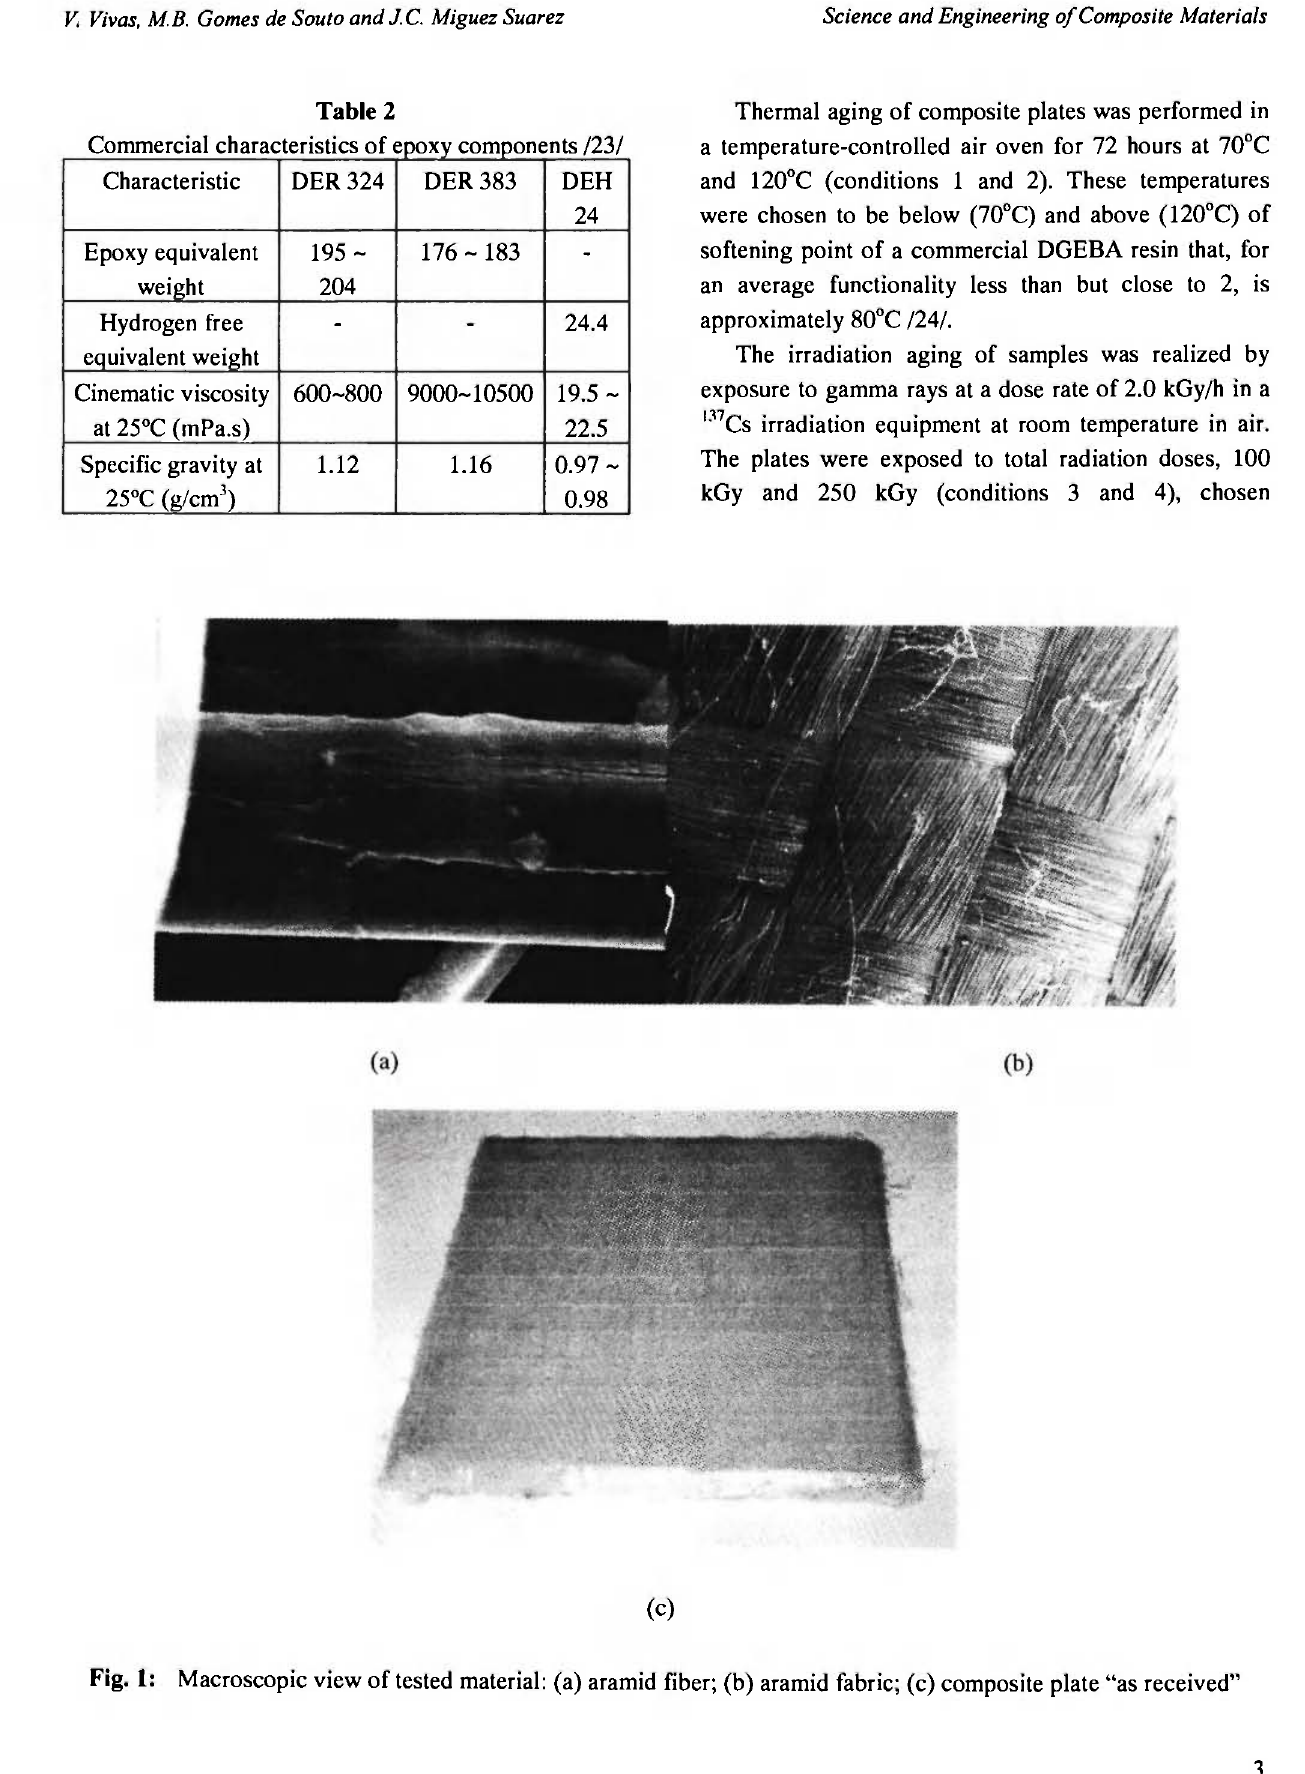
Fig. 1: Macroscopic view of tested material: (a) aramid fiber; (b) aramid fabric; (c) composite plate "as